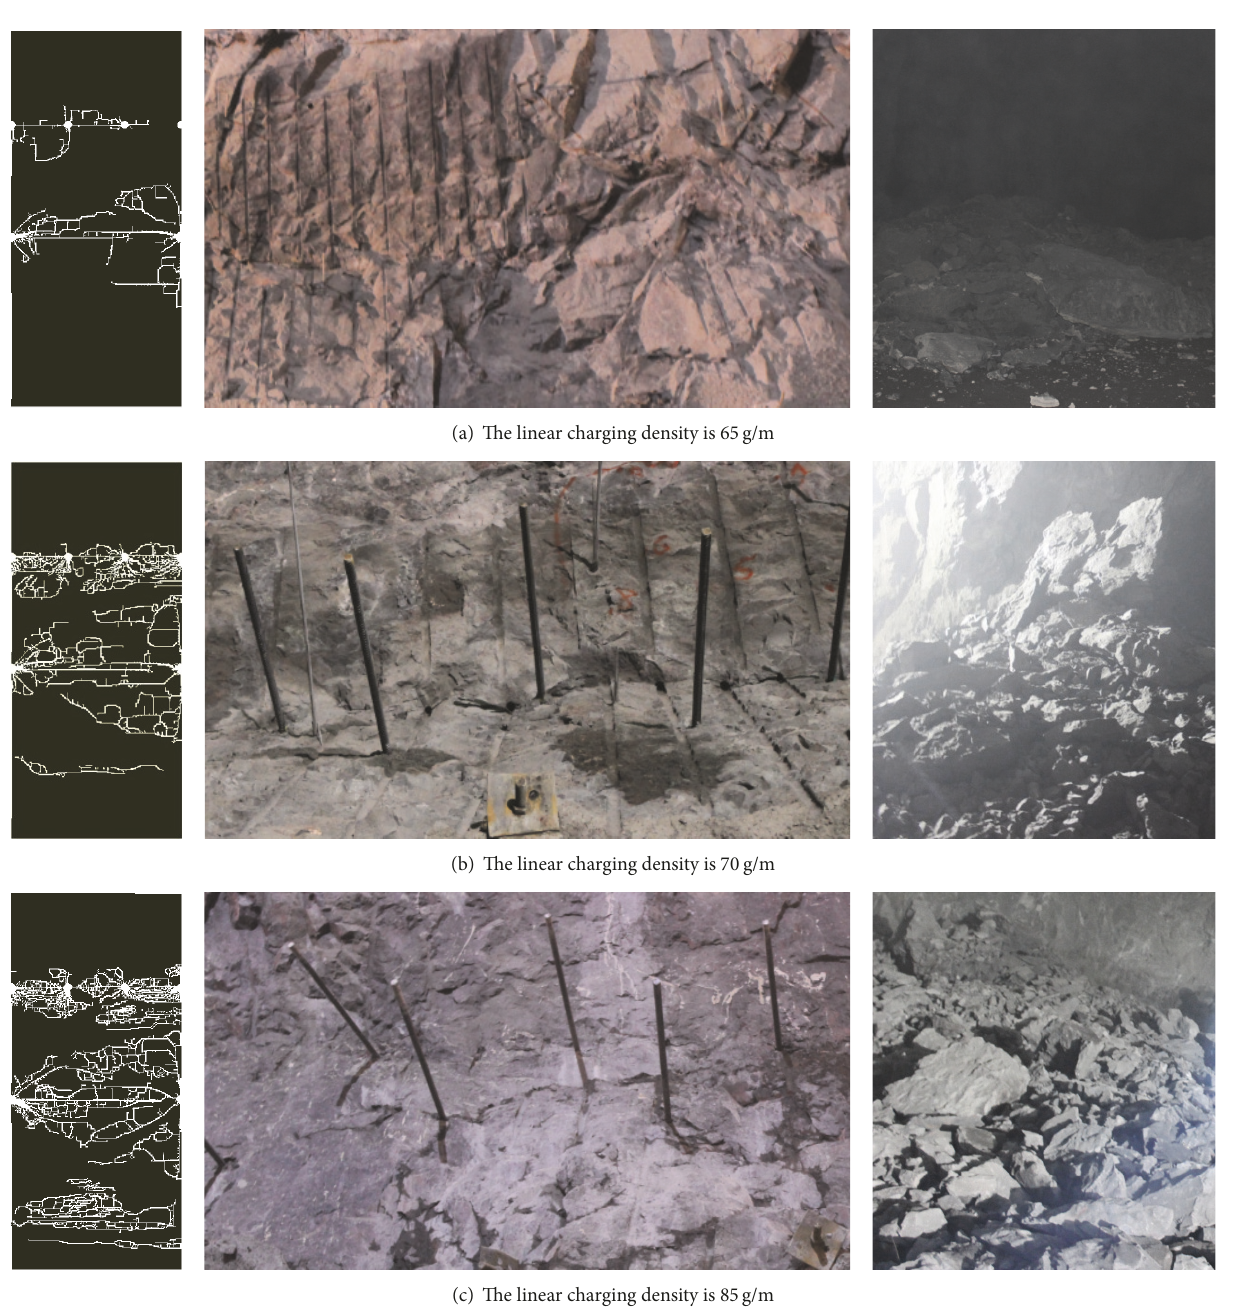
Figure 12: The comparison of excavated contour and crushing rate of rock mass in numerical simulation and field measurement under different charge